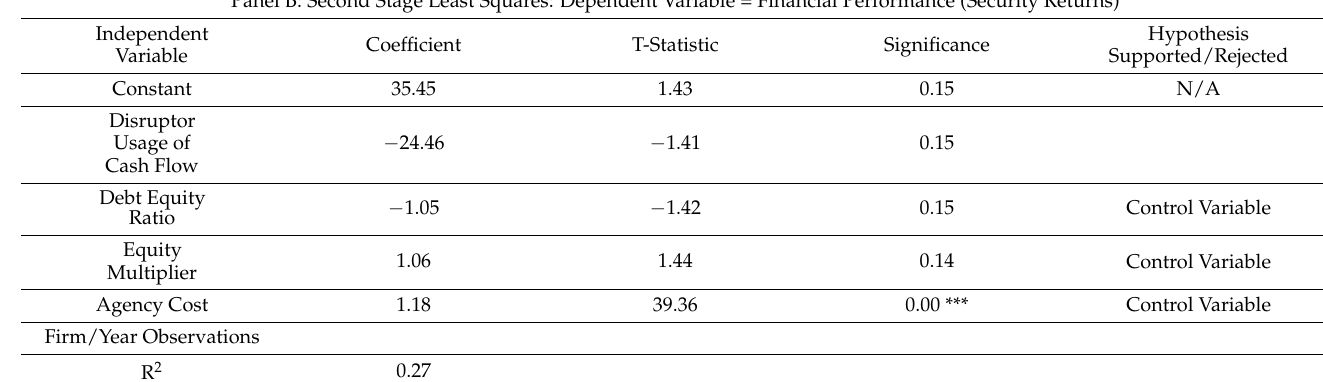
Panel B: Second Stage Least Squares: Dependent Variable = Financial Performance (Security Returns)